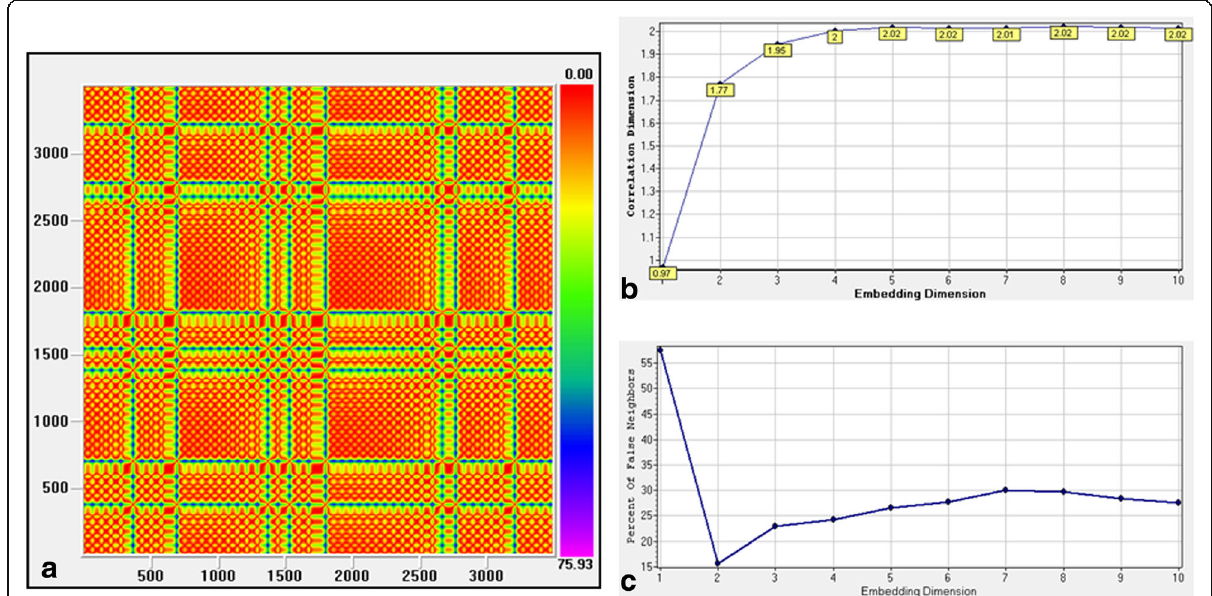
Fig. 7 Recurrence plot and embedding dimension for the Lorentz system. a Recurrence plot. The colour code to the side of a indicates that ε / c varies from 0 to 76. b Correlation dimension plotted against embedding dimension. The plot departs from a slope of 45 o (equivalent to white noise) at an embedding dimension of 2 giving an estimate for the true embedding dimension of the attractor. c Percentage of false nearest neighbours plotted against embedding dimension. The minimum is at 2 indicating again that this is close to true embedding dimension for the system. The theoretical value of the dynamical dimension is 2.17